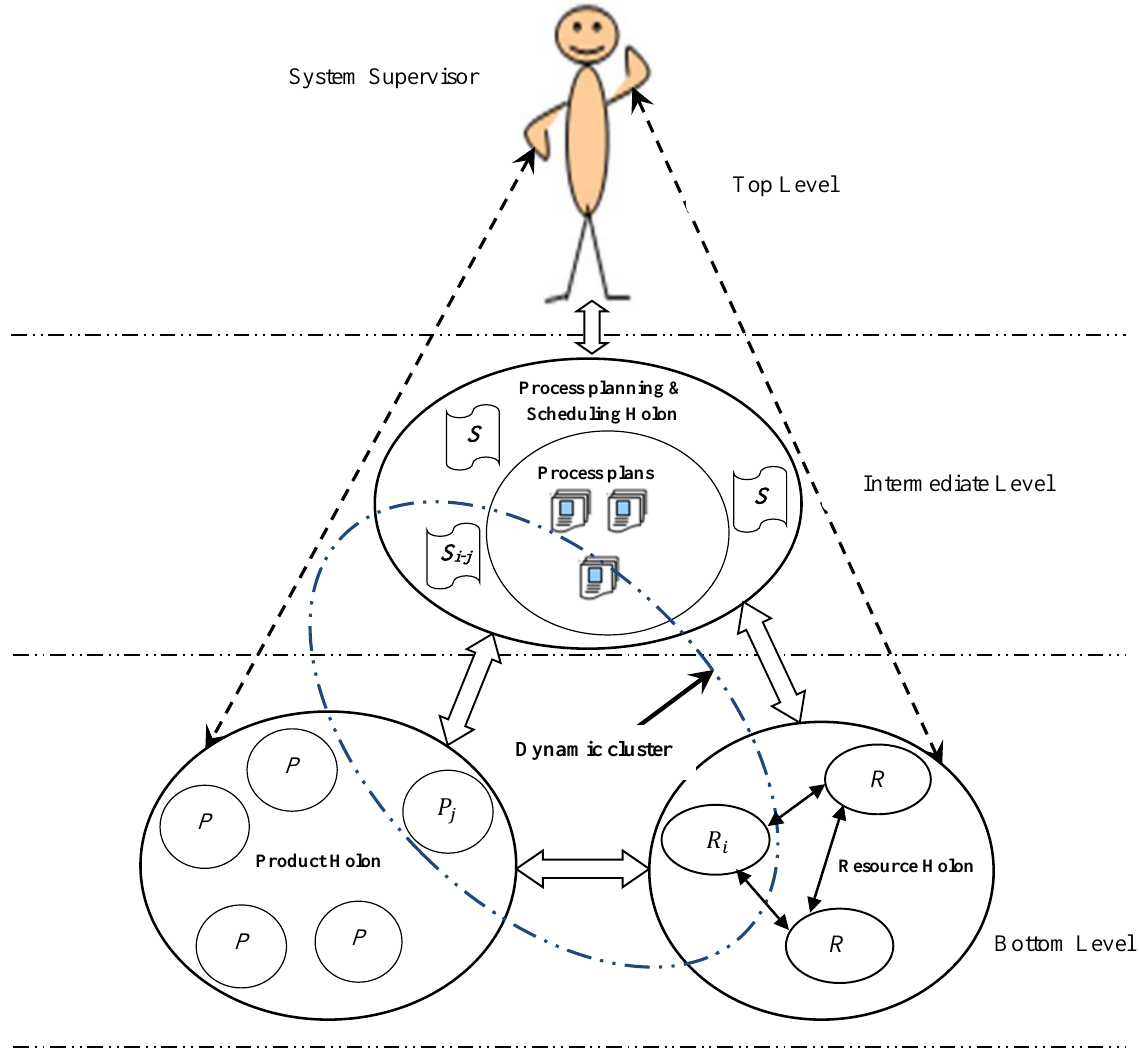
Fig. 2. Multi Agent based Holonic Adaptive Scheduling (MAHoAS)